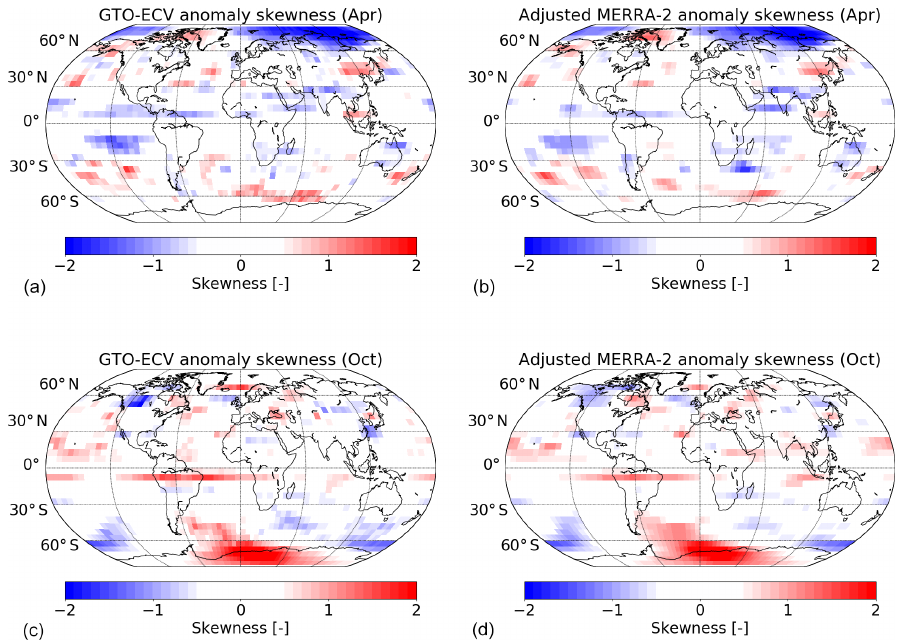
Figure 12. Skewness of the ozone anomaly distributions for GTO-ECV (a, c) and adjusted MERRA-2 (b, d) data records for April (a, b) and October (c, d) . Only values exceeding the standard deviation of the skewness ( σ skew = 0 . 51) are